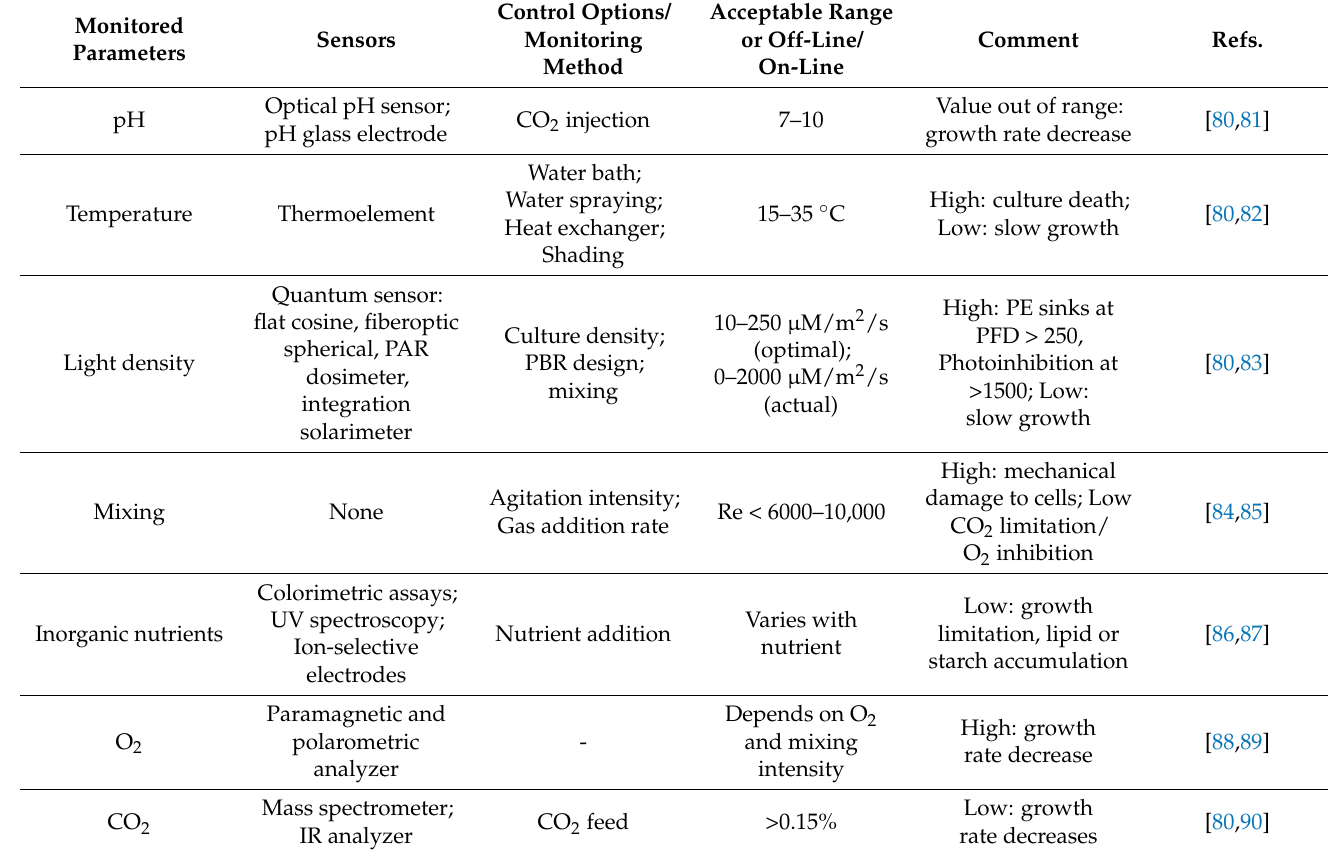
Table 1. Factors monitored and analyzed in microalgae cultivation